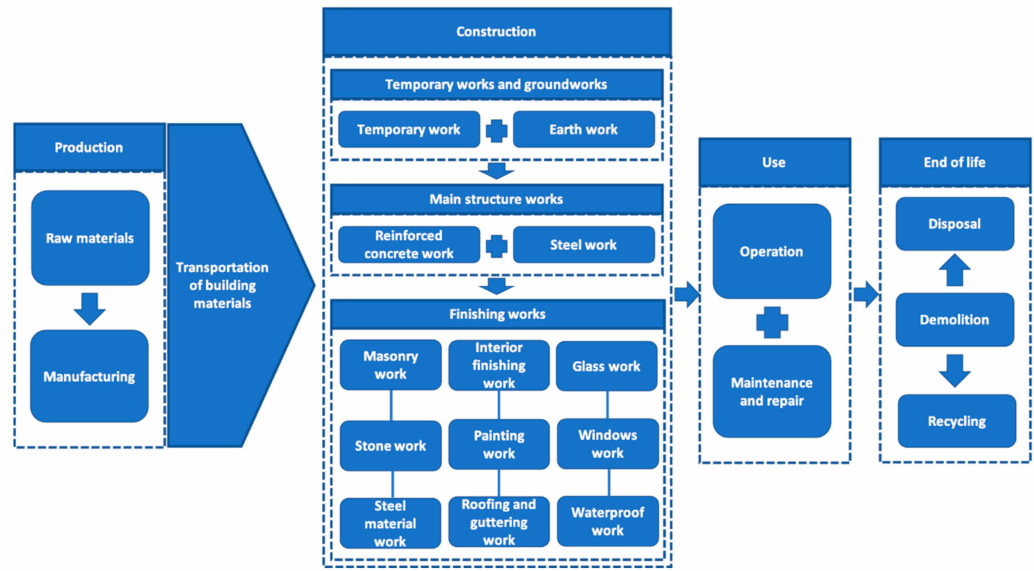
Figure 1. The life cycle of and construction work of a building.